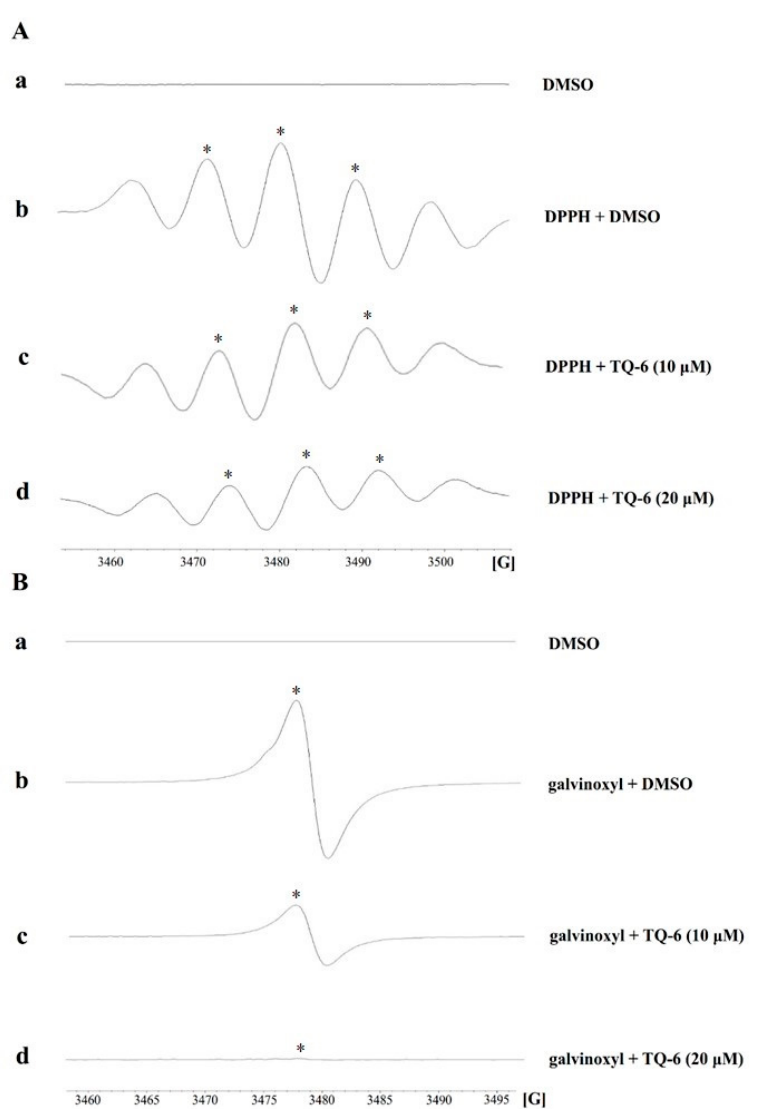
Figure 1. Scavenging effect of TQ-6 on 1,1-diphenyl-2-picrylhydrazyl (DPPH) and galvinoxyl radicals. ( A ) The reaction mixture contained 1.0 mM DPPH in the presence or absence of TQ-6. Line a, DMSO (0.1%) without DPPH; Line b, dimethyl sulfoxide (DMSO); Line c, 10 µ M TQ-6; and Line d, 20 µ M TQ-6 with DPPH. ( B ) TQ-6 with different concentrations were mixed with 500 µ M galvinoxyl. Line a, DMSO (0.1%) without galvinoxyl; Line b, DMSO; Line c, 10 µ M TQ-6; and Line d, 20 µ M TQ-6. Spectra are representative examples of four similar experiments. The horizontal axis means the magnetic field [G].